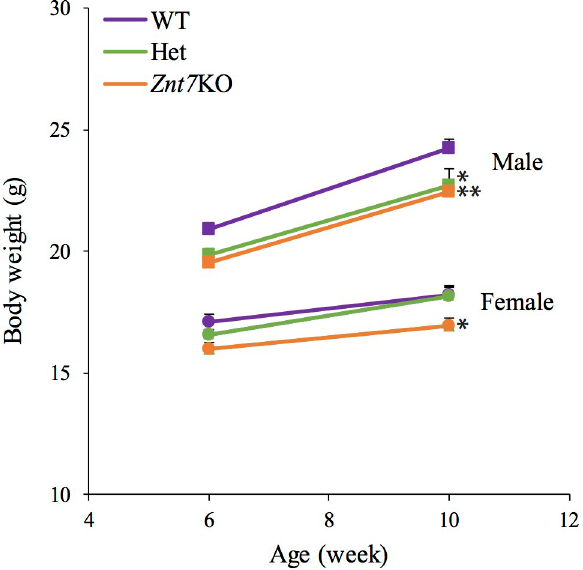
Fig 1. Znt7 -/- mice show reduced body weight after 4 weeks on a semi-purified diet (30 mg/kg Zn). Offspring, including Znt7 -/- , Znt7 +/- , and WT produced from Znt7 +/- breeding pairs, were fed a semi-purified rodent diet containing 30 mg Zn/kg ad libitum between 6- and 10-weeks of age. Body weights obtained at 6- and 10-weeks of age are shown. All values are expressed as mean ± S.E. ( error bars ), n = 6-12/group. � , p < 0.05 (to the WT control in the same sex group); �� , p < 0.01 (to the WT control in the same sex group). WT, wild type control mice; Het, heterozygous Znt7 knockout mice; Znt7 KO, homozygous Znt7 knockout mice.